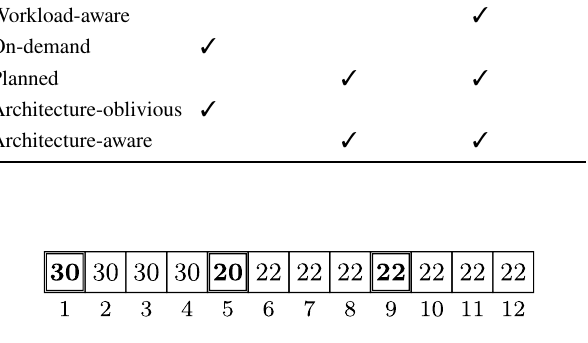
Fig. 6 Representation of the new batch estimator. The bold numbers are the estimated number of neighbors of those points, while the other numbers are inferred, based on the maximum result between the two closest estimated points shown in